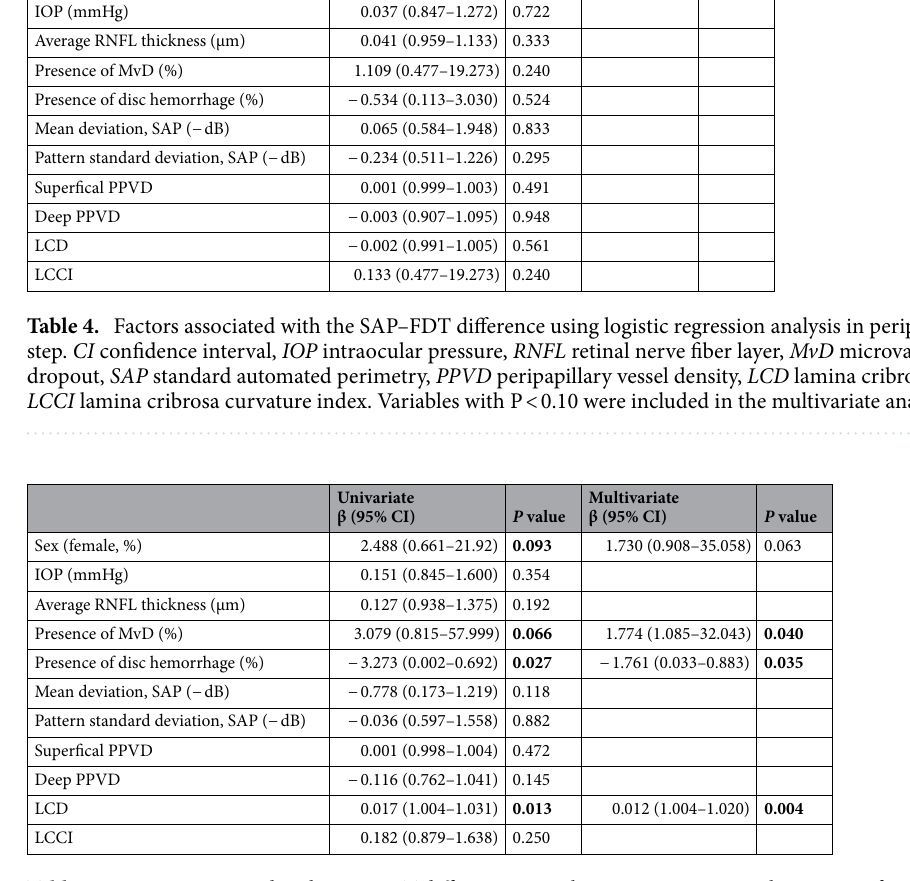
Table 5. Factors associated with SAP–FDT difference using logistic regression analysis in parafoveal scotoma. CI confidence interval, IOP intraocular pressure, RNFL retinal nerve fiber layer, MvD microvascular dropout, SAP standard automated perimetry, PPVD peripapillary vessel density, LCD lamina cribrosa depth, LCCI lamina cribrosa curvature index. Variables with P < 0.10 were included in the multivariate analysis. Factors with statistical significance are shown in